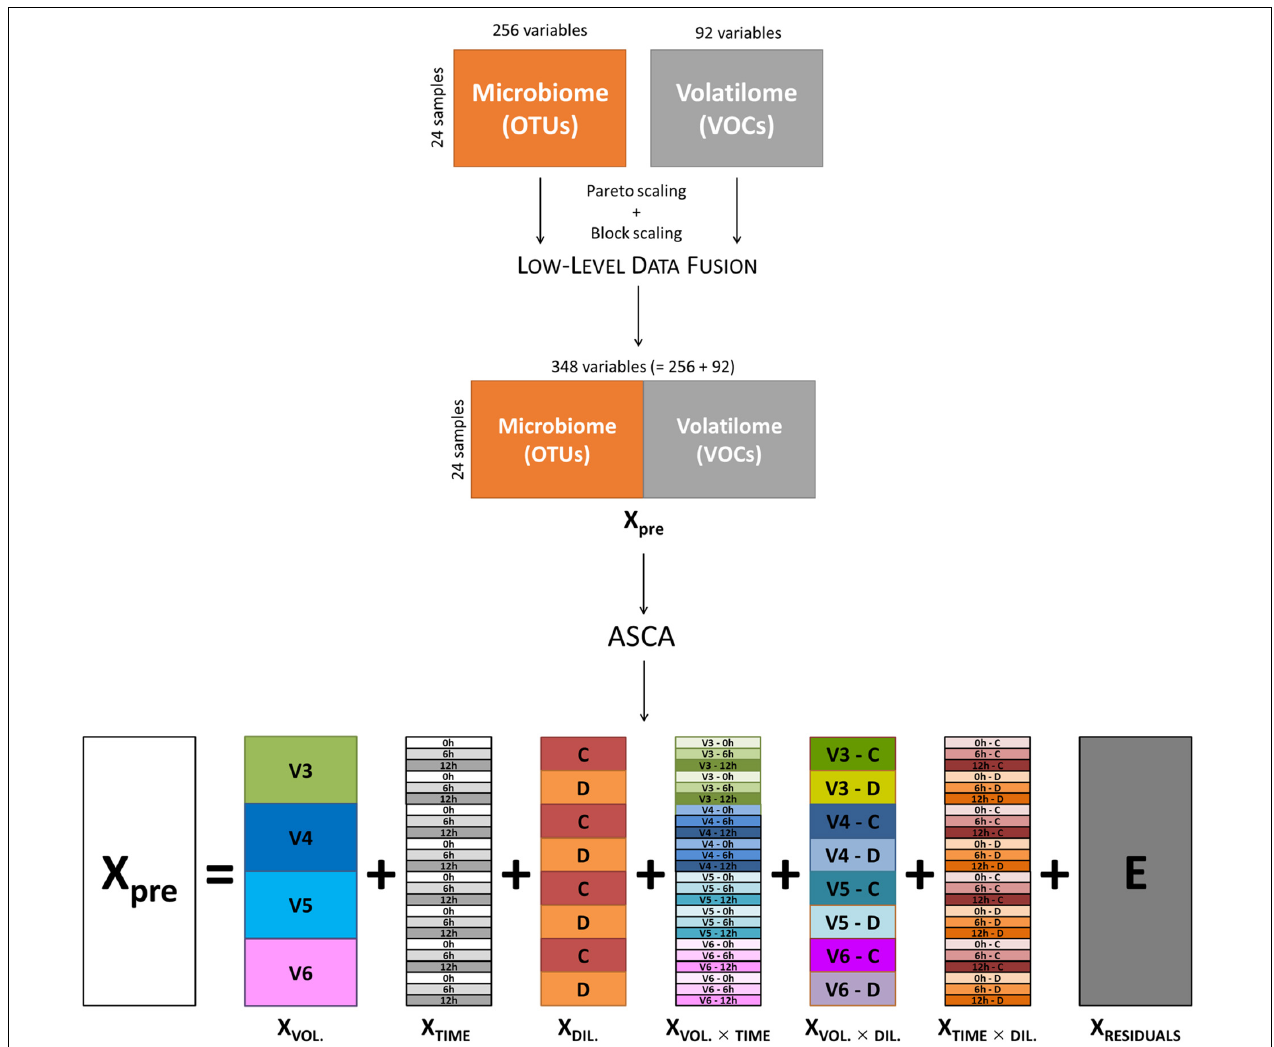
FIGURE 1 | Schematic representation of low-level data fusion of microbiome and volatilome data, and ASCA decomposition of fused dataset. ASCA, ANOVA simultaneous component analysis.